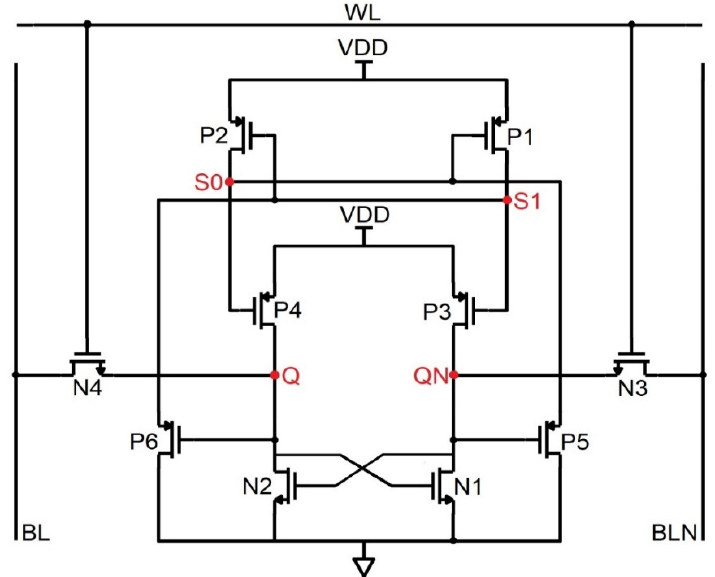
Figure 9. Schematic of the 10T SRAM configuration.